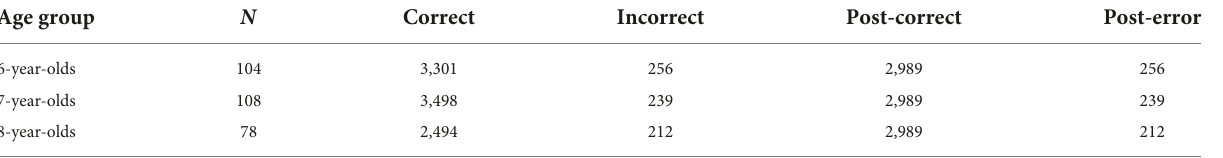
TABLE 1 Number of observations underlying the analyses concerning the Flower block.